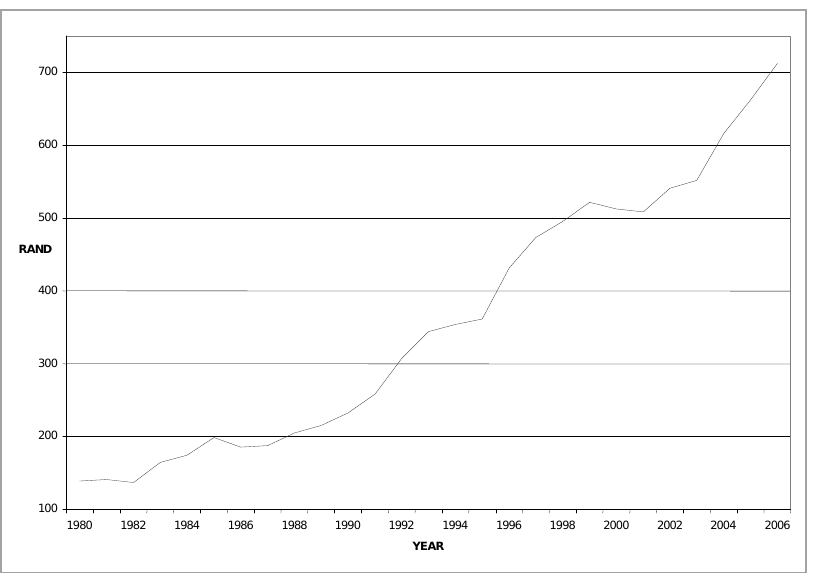
in South Africa: